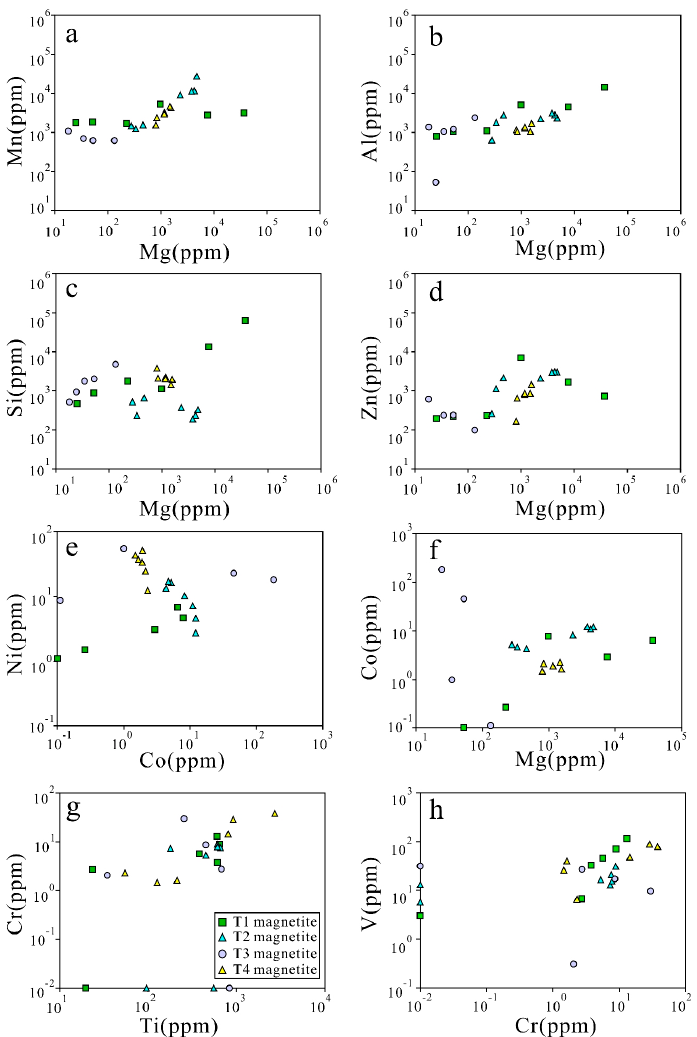
Figure 6. Binary diagrams of ( a ) Mn vs. Mg, ( b ) Al vs. Mg, ( c ) Si vs. Mg, ( d ) Zn vs. Mg, ( e ) Ni vs. Co, ( f ) Co vs. Mg, ( g ) Cr vs. Ti, and ( h ) V vs. Cr for the Huanggangliang disseminated- and massive-magnetite ores.